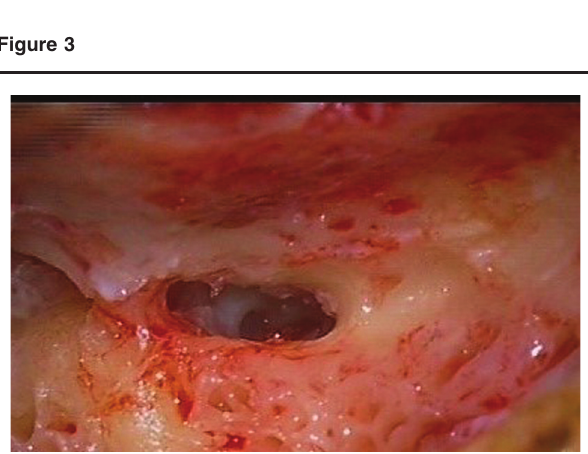
RWN depth according to our proposed method. RWN, round window niche.